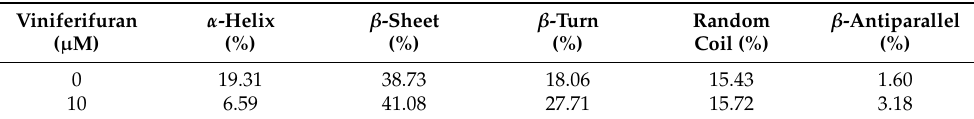
Figure 7. The curve-fitted amide band I of free XO ( A ) and viniferifuran–XO ( B ). Table 1. The contents of the secondary structures of free XO and viniferifuran–XO determined by